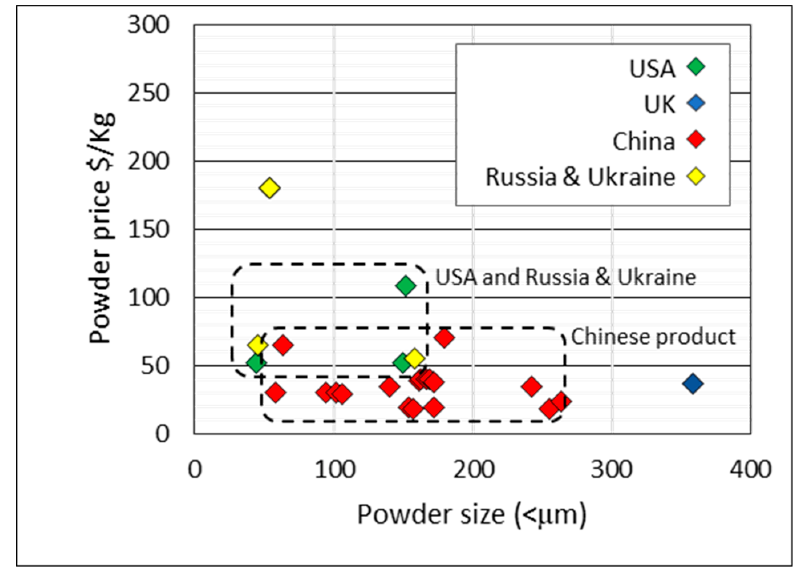
Figure 15. Price per kg of titanium powder (HDH and sponge fines) and powder size (< μ m). Country of origin indicated by color.